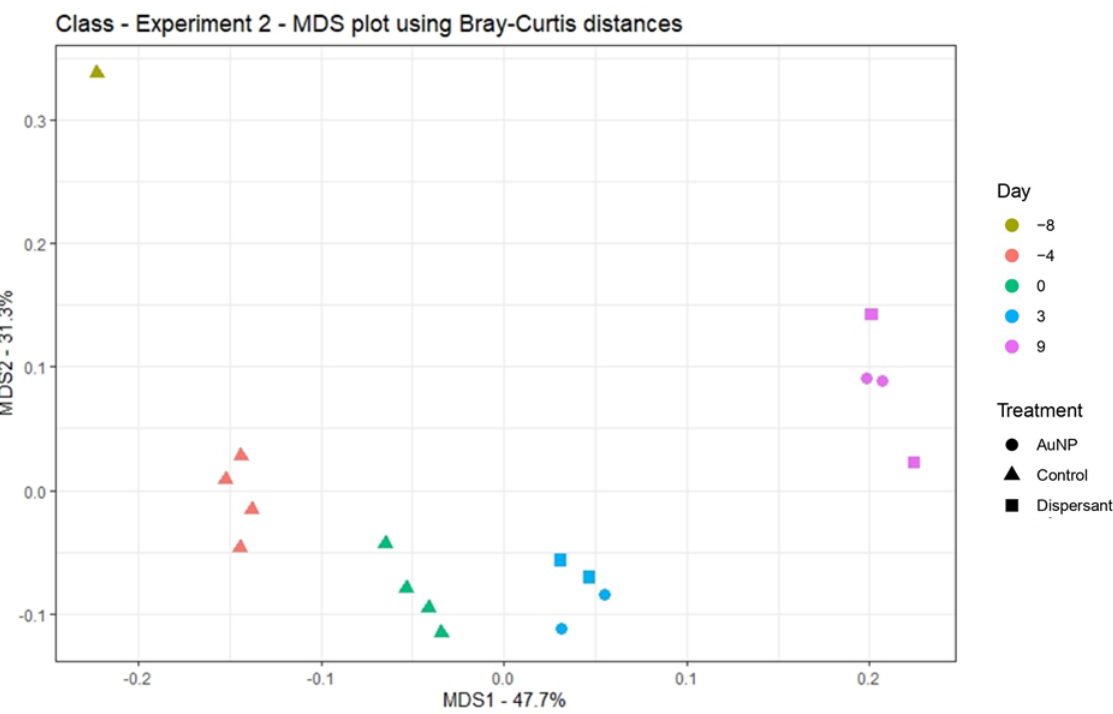
Figure 4. PCoA of bacterial communities, evaluated to class level, using Bray–Curtis distance. Scheme 8: Red (day −4), green (day 0), blue (day 3), and purple (day 9).